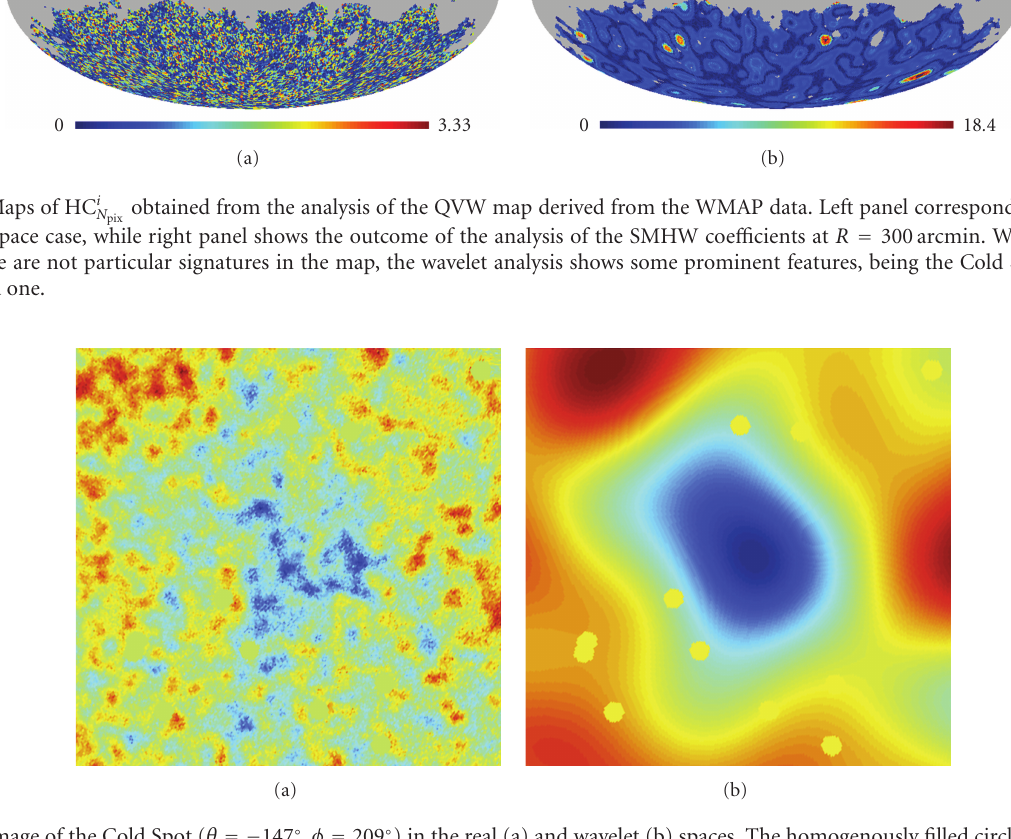
Figure 7: Image of the Cold Spot ( θ = − 147 ◦ , φ = 209 ◦ ) in the real (a) and wavelet (b) spaces. The homogenously filled circles correspond to positions where known extragalactic point sources have been